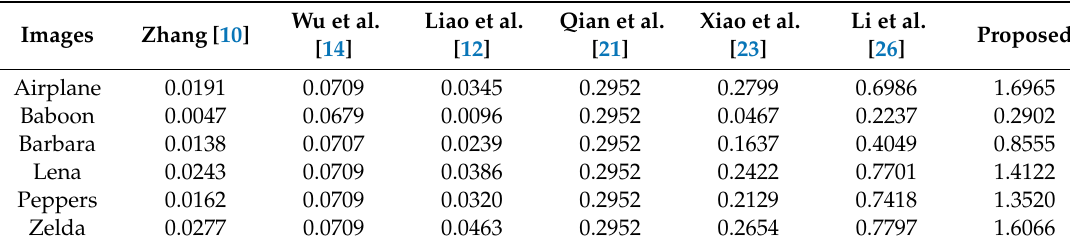
Table 1. Comparison of the embedding rates